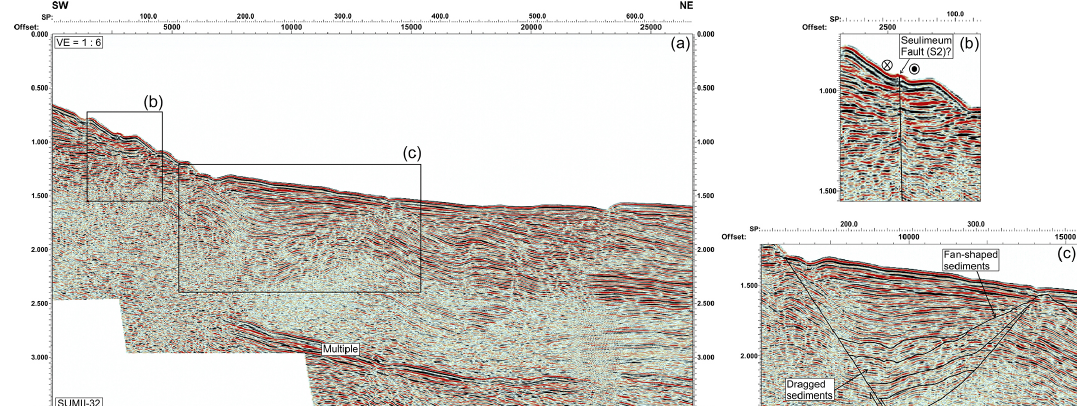
Figure 2. Seismic sections of SUMII-32 that have been collected from 1991 to 1992 by Malod and Kemal (1996). This dataset is digitized from paper recordings that were scanned and converted to digital images. All seismic traces were digitized and converted into the SEG- Y format for reprocessing. Please see Sect. 3.1 for detailed processing of this dataset. (a) The reprocess uninterpreted seismic profile with direction, shot point (SP) and offset (in meters) presented at the top of the profile. (b) Possible location of the Seulimeum fault. (c) Fan-shaped sediments.